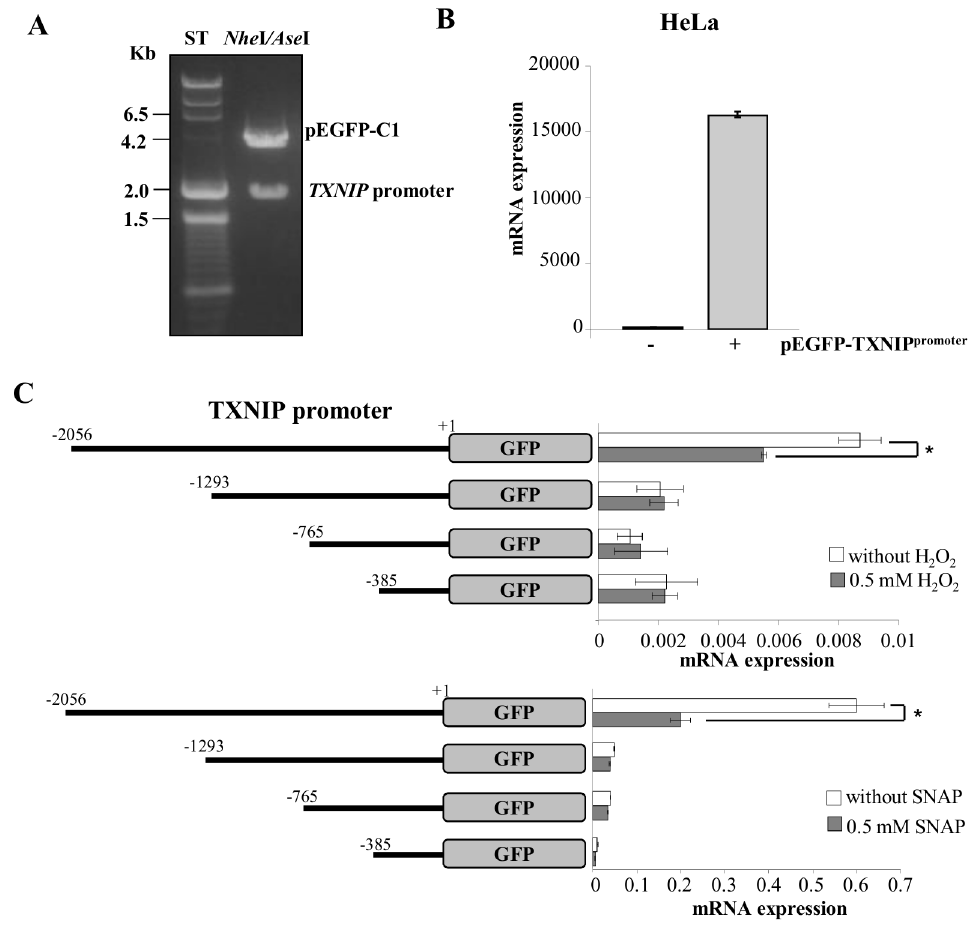
Figure 4. TXNIP promoter construction and regulation of its expression by oxidative and nitrosative stress. ( A ) Scheme representing the molecular cloning of TXNIP’s promoter region replacing the pEGFP-C1 CMV’s promoter region. ( B ) HeLa wild-type cells were transiently transfected with the TXNIP promoter construction and relative levels of GFP mRNA were determined by real- time PCR. ( C ) HeLa cells permanently transfected with the different TXNIP promoter constructs were stimulated with H or SNAP (0.5 mM). Treatments stimulated strong suppression of GFP expression only in cells transfected with the –2056 base pairs TXNIP promoter construct. Values are reported in the bar graphs and expressed as means ± S.D. (n = 3, * p <0.05). doi: